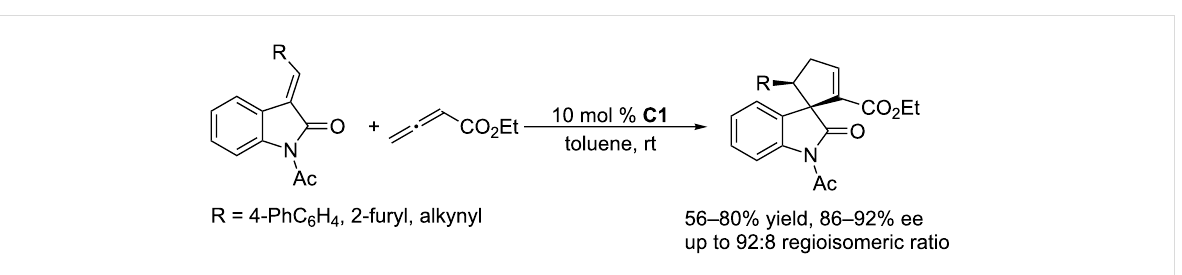
Scheme 12: Asymmetric [3 + 2] annulations of 3-alkylidene-oxindoles with ethyl allenoate, catalyzed by the ferrocene-modified phosphine C1 .